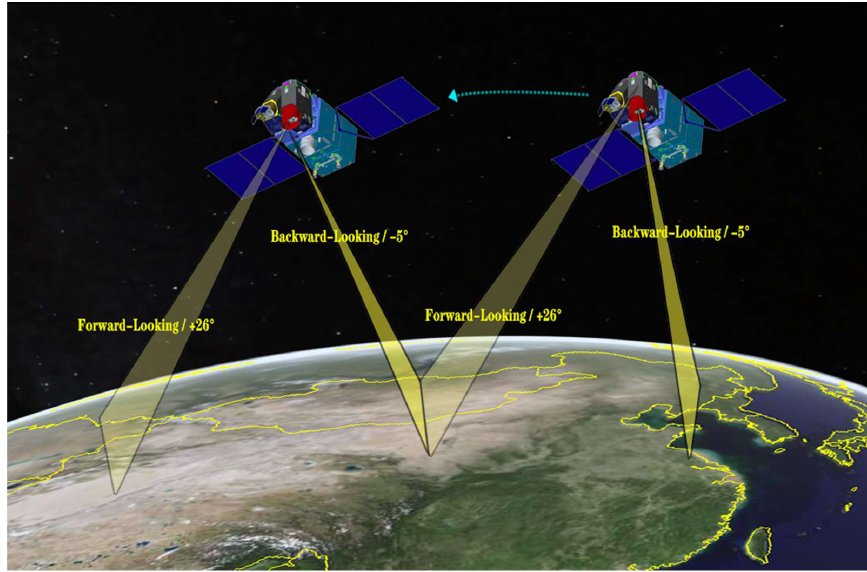
Figure 1. The DLC (forward-looking and backward-looking cameras) of the GF7 satellite.